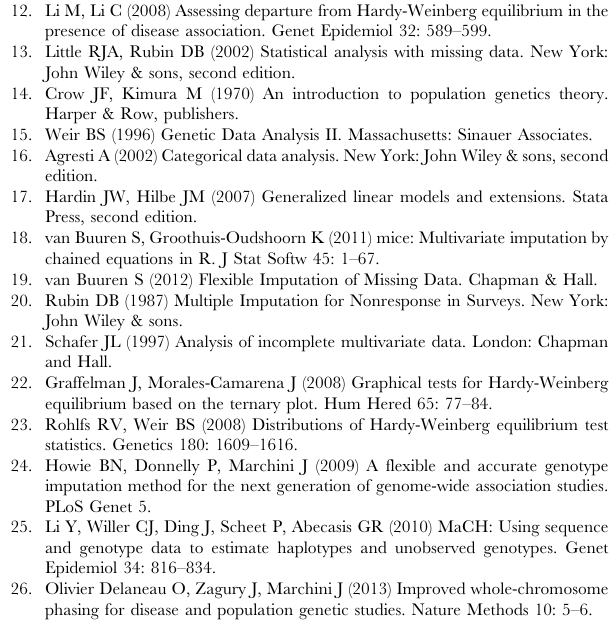
Figure S1 Convergence plots of the inbreeding coeffi- cients for five models using MICE from Table